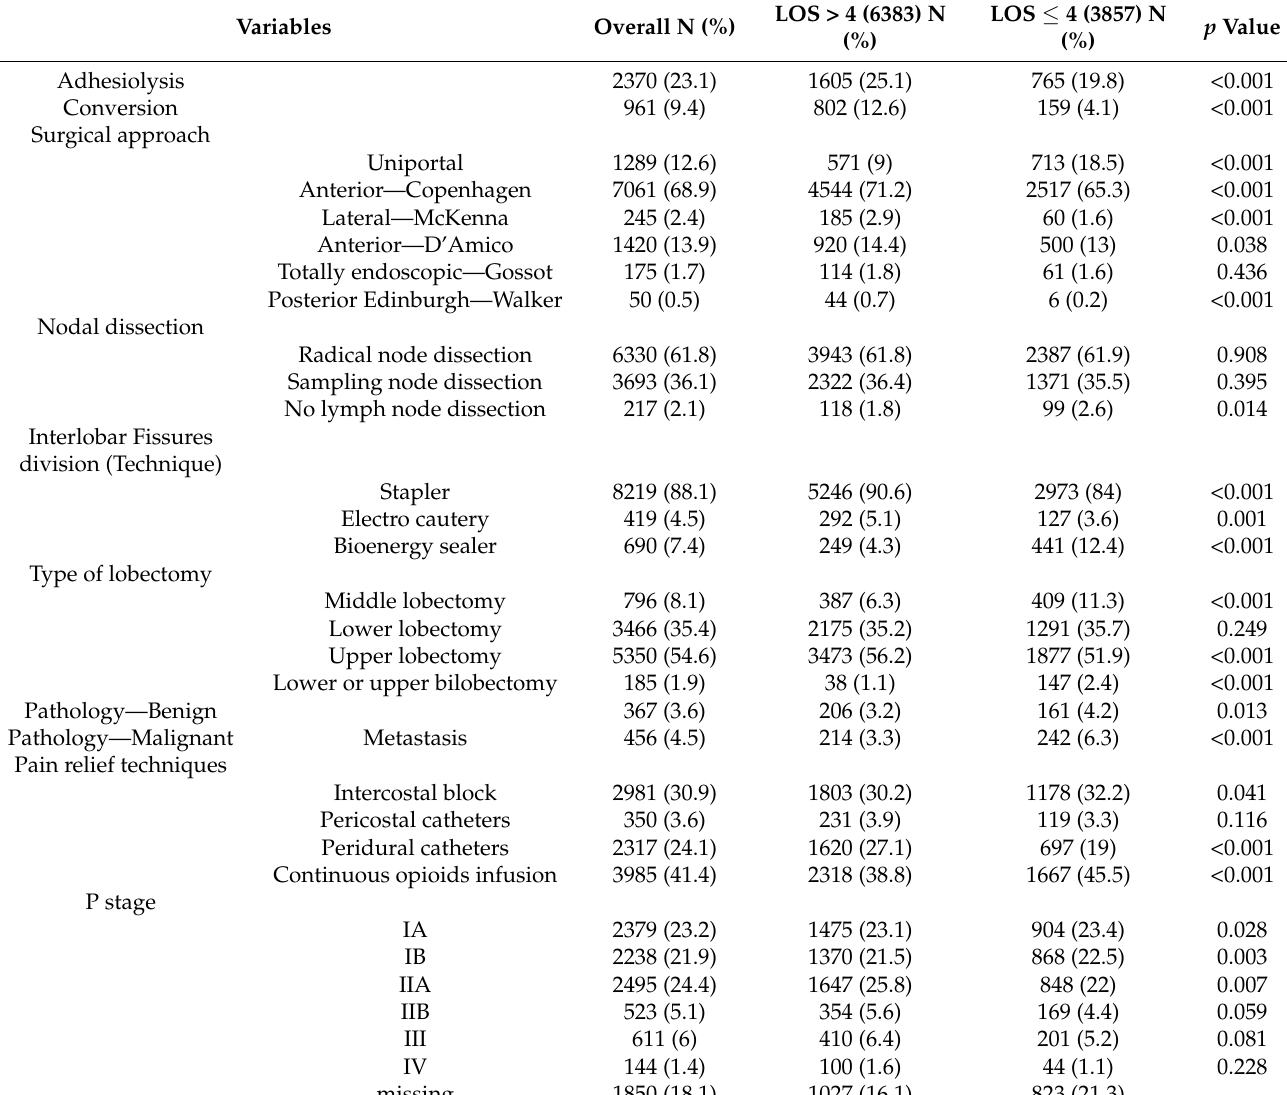
Table 5. Patients’ surgical